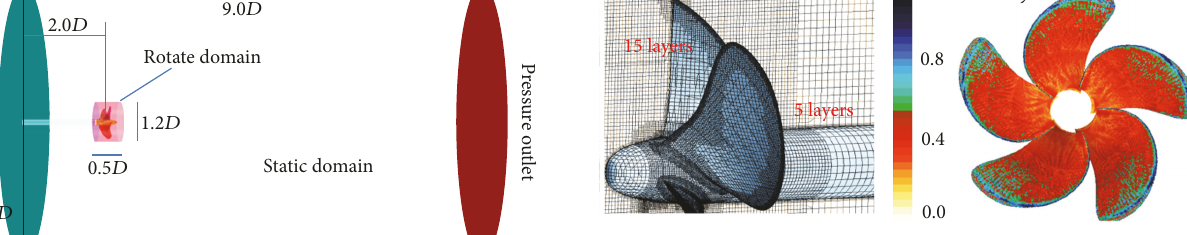
Figure 16: Computational meshes near the blade and wall 𝑦 + on the blade surface. Table 5: Grid refinement study based on predicted thrust coeffi- cients, 𝐽 = 0.6